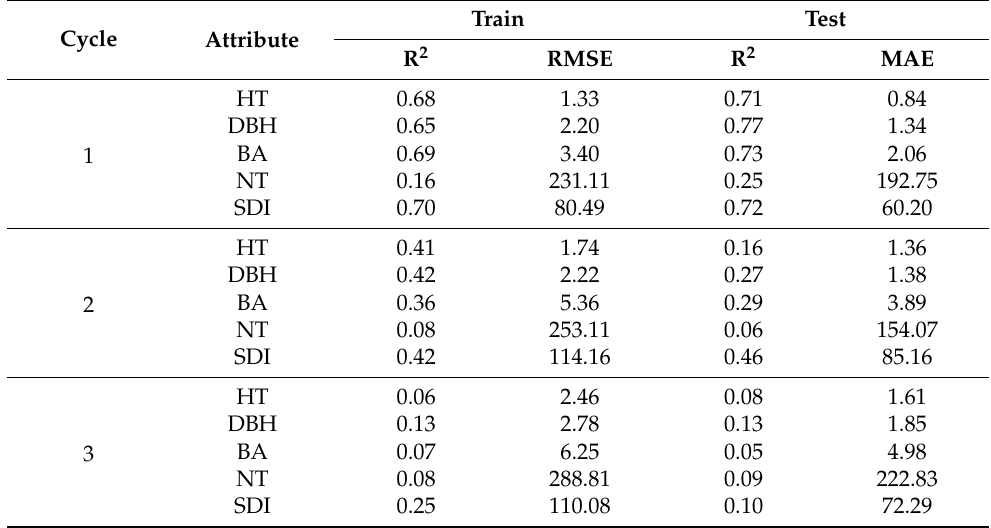
Table 8. Final random forests models by cycle and stand attribute including model